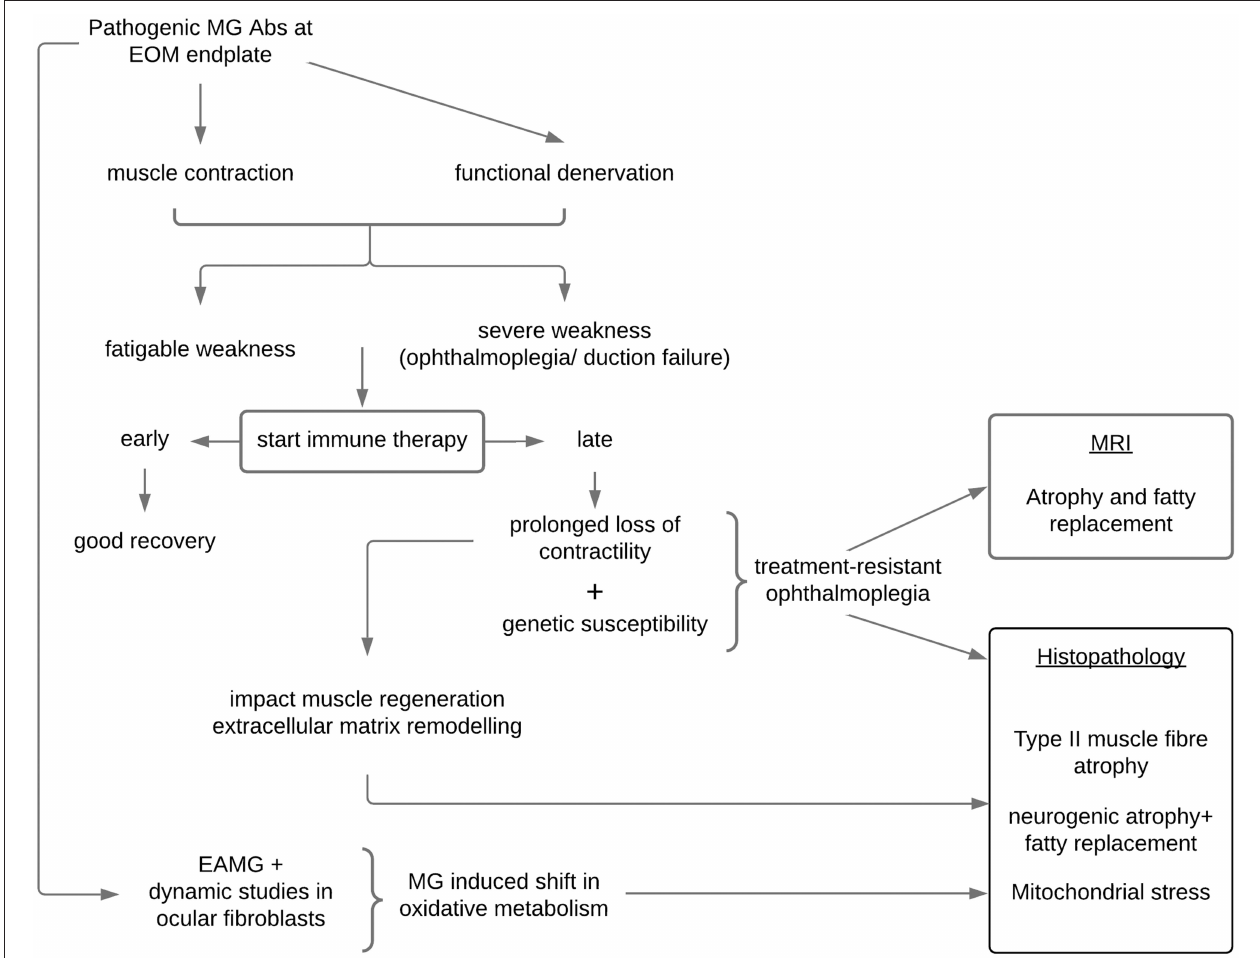
FIGURE 1 | Proposed mechanisms in the development of treatment-resistant ophthalmoplegia in susceptible patients with myasthenia gravis. EOM, extraocular muscles; MRI, magnetic resonance imaging of the orbit; EAMG, experimental autoimmune myasthenia gravis; Abs, antibodies.